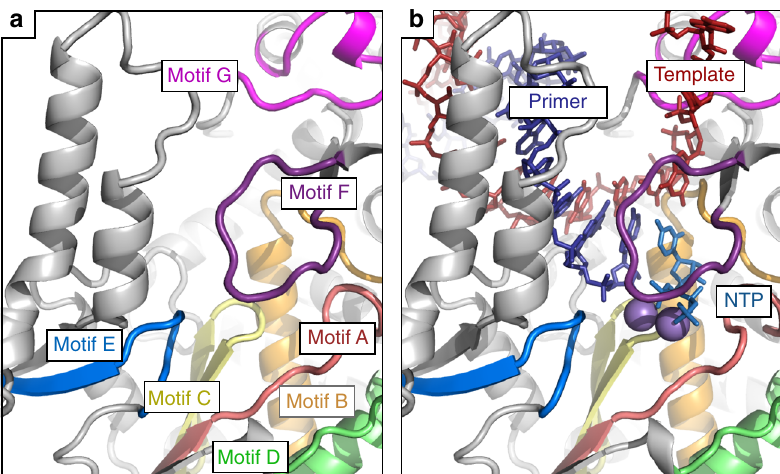
Fig. 3 Architecture of the nsp12 polymerase-active site. a RNA polymerases possess seven conserved motifs (motifs A – G) involved in template binding (motif G), NTP binding (motif F), and polymerization (motifs A – E). b Superposition of elongation complexes from poliovirus 24 (3OL6.pdb) [10.2210/ pdb3OL6/pdb] and norovirus 25 (3H5Y.pdb) [10.2210/pdb3H5Y/pdb] polymerases give the approximate positions of RNA template (red), primer (dark blue), incoming NTP (blue), and bound catalytic metal ions